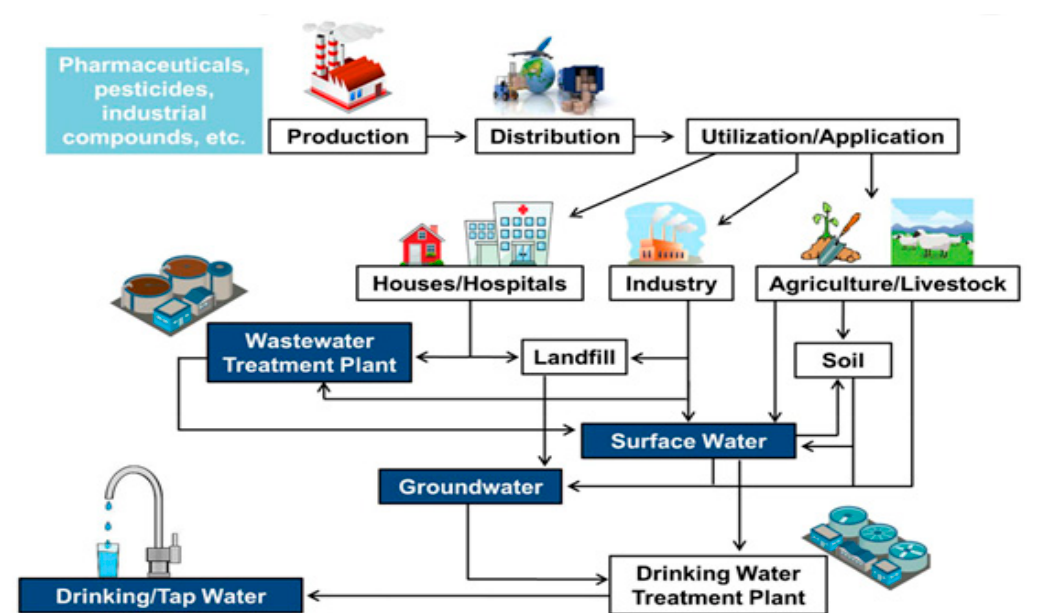
Figure 1. Typical routes and sources of endocrine-disrupting (EDCs) contaminants in the environment [43].